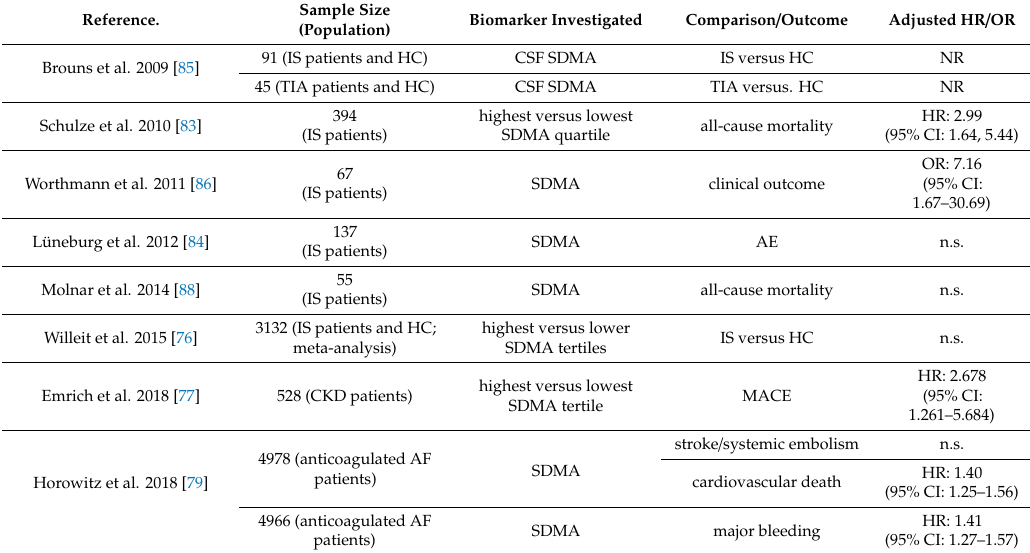
Table 1. Overview on selected clinical studies and meta-analyses evaluating ADMA in cerebrovascular diseases.